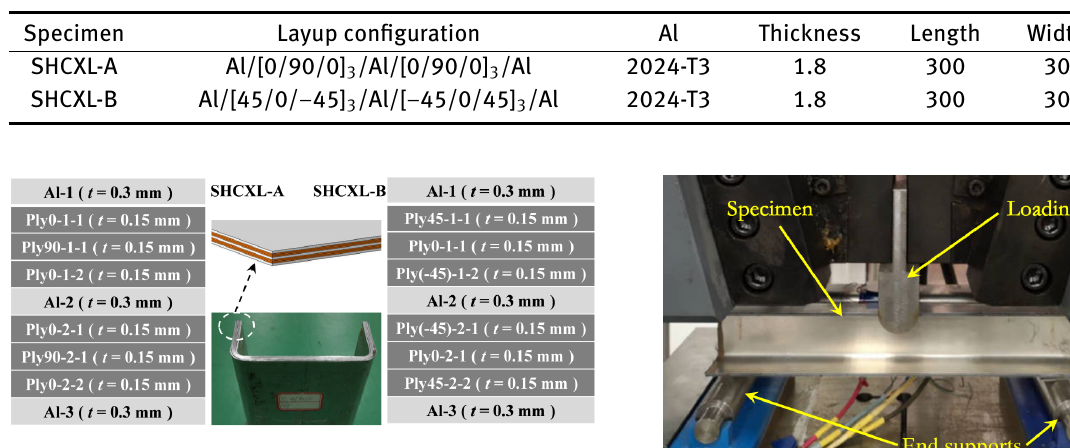
Table 1: Double-channel cross-section member notations, layup sequence, and dimensions (unit: mm).